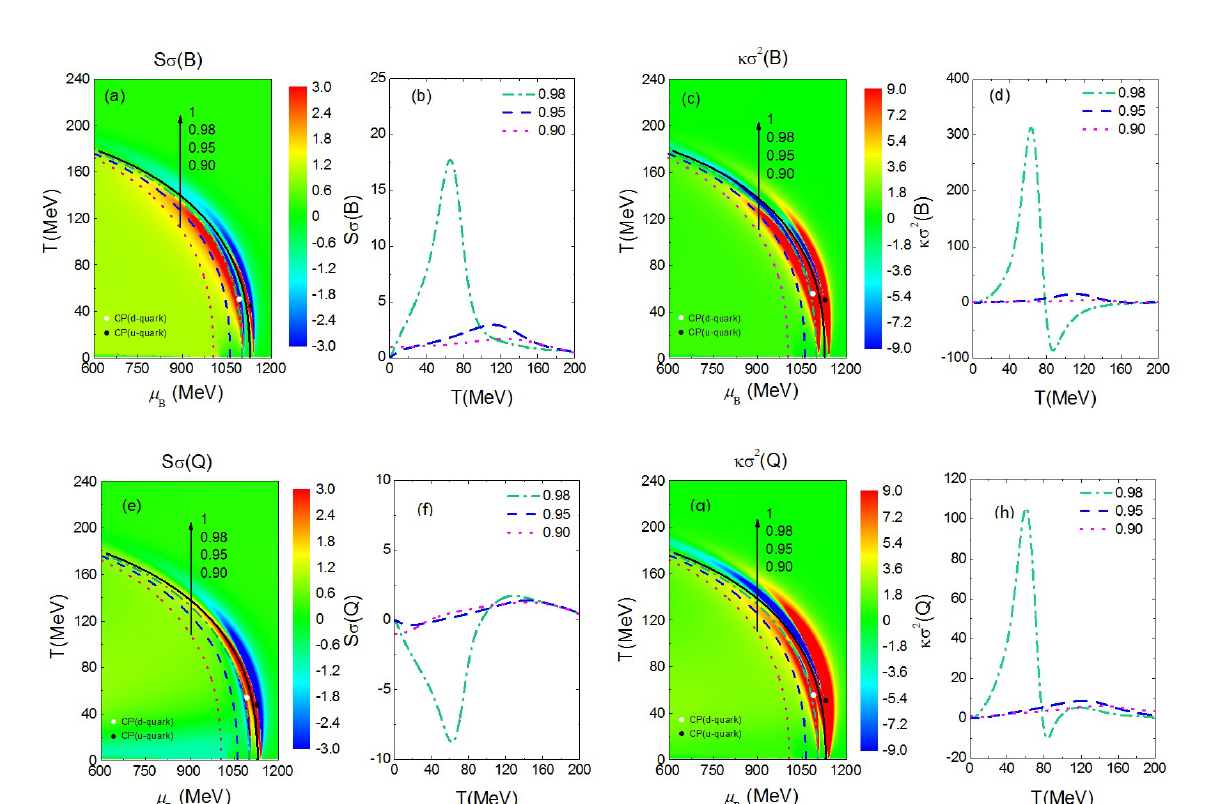
Figure 2. (color online) Density plot of S σ ( a , b , e , f ) and κσ 2 ( c , d , g , h ) in the µ B − T plane as well as those along the different hypothetical chemical freeze-out lines with the scalar–isovector coupling constant R IS = 0.14 and the empirical relation µ I = − 0.293 − 0.0264 µ B with both µ B and µ I in MeV. The solid line represents the averaged chiral phase transition boundary for u and d quarks, while the other lines are hypothetical chemical freeze-out lines by rescaling µ B of the solid line with factors of 0.98, 0.95, and 0.90. The upper panels are the net-baryon (B) susceptibilities while the lower panels are the net-charge (Q)